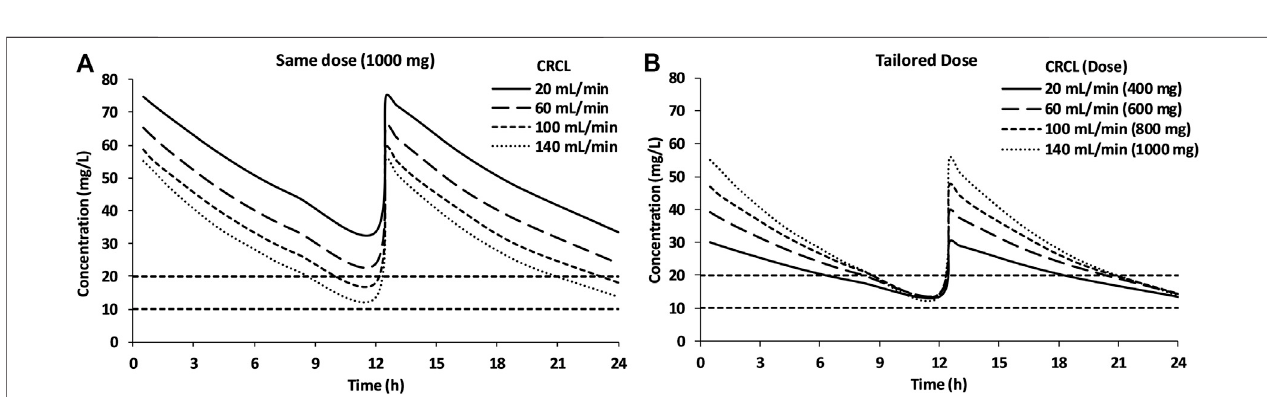
FIGURE 5 | Simulations of the 1,000-mg q12h dose for patients with different renal status (A) and simulation of tailored dose based on the renal status of the patients (B) .